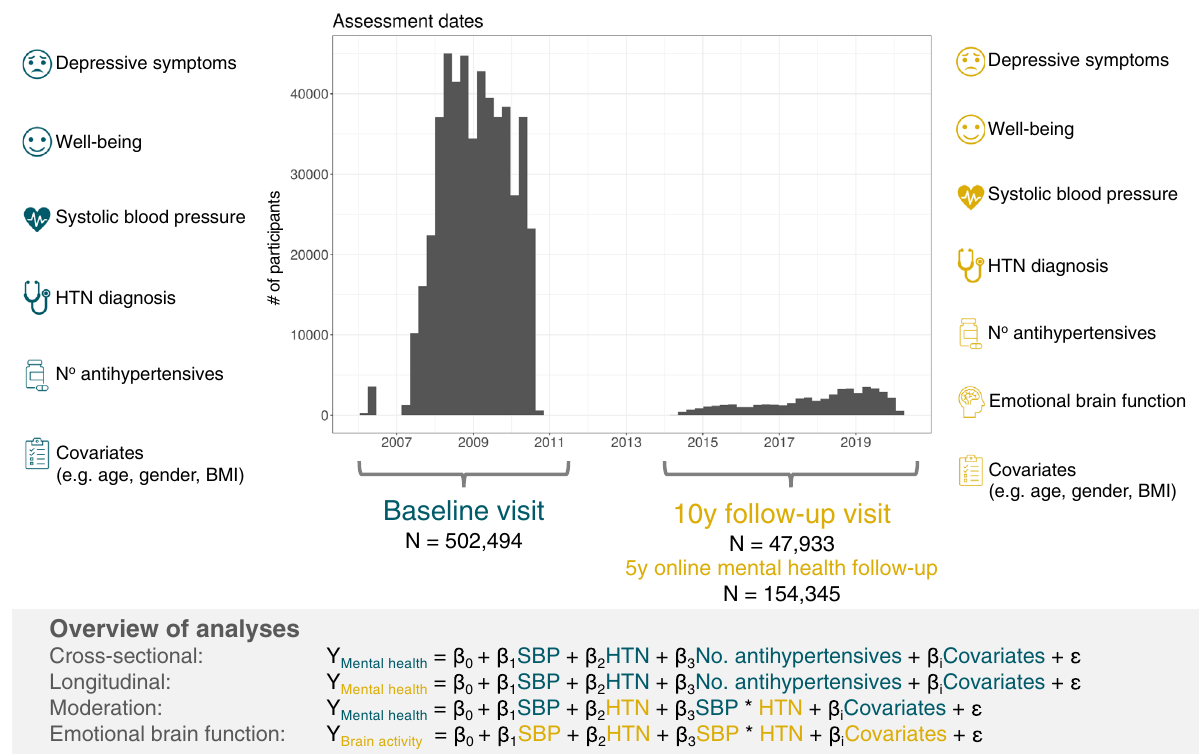
Fig. 1 | Schematic overview of study design, outcome and predictor variables and analyses. Our study included UK Biobank data (i) from the complete baseline assessment, which was conducted between 2006 – 2010, and (ii) from the ongoing 10-year follow-up visit which has started in 2014 and included brain magnetic resonance imaging (MRI). Our follow-up visit sample consisted of those partici- pantswhosedatahadbeenreleasedbyFebruary2020.Inaddition,asub-sampleof thebaselinecohortparticipatedinanonlinementalhealthfollow-upassessmentin